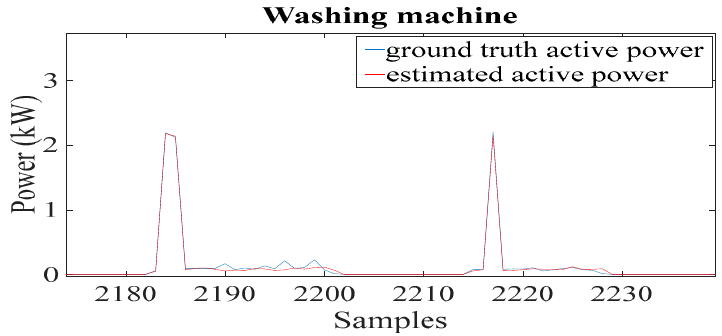
Figure 4. Fridge: blue, ground truth active power; red, estimated active power.